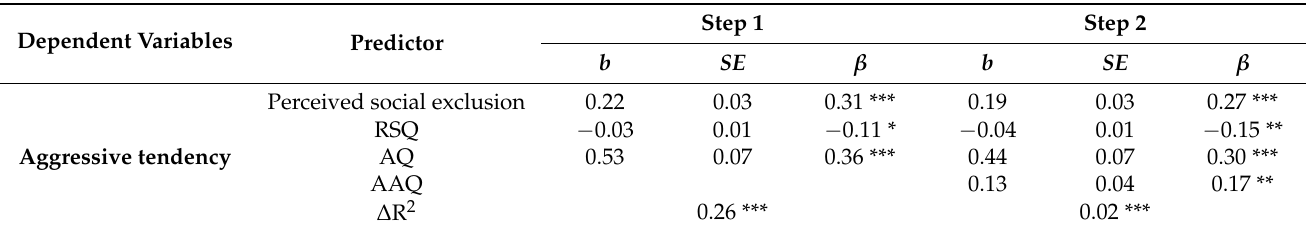
Table 2. The results of the hierarchical multiple regression analysis of aggressive tendency with trait